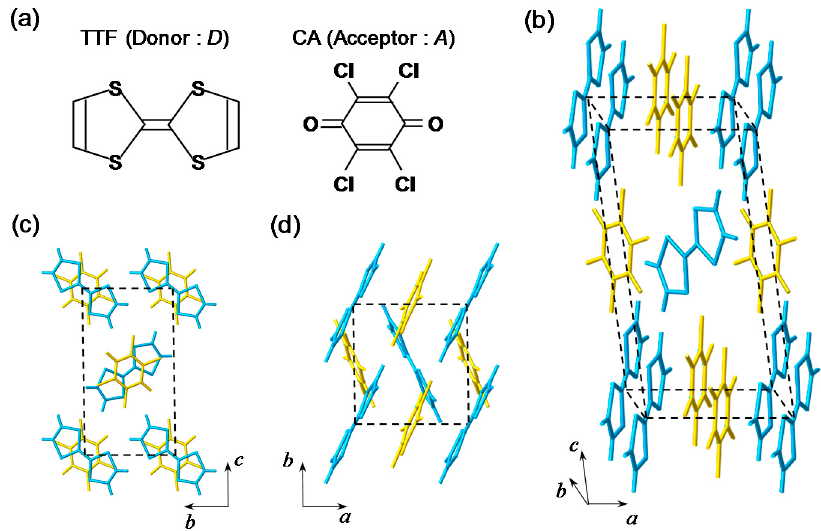
Figure 2. ( a ) Molecular structures of TTF and CA; ( b ) Three-dimensional crystal structure of TTF-CA; ( c , d ) Crystal structure of TTF-CA projected on ( c ) bc plane and ( d ) ab plane. Classification of photoinduced phase transition dynamics from A phase to B phase.